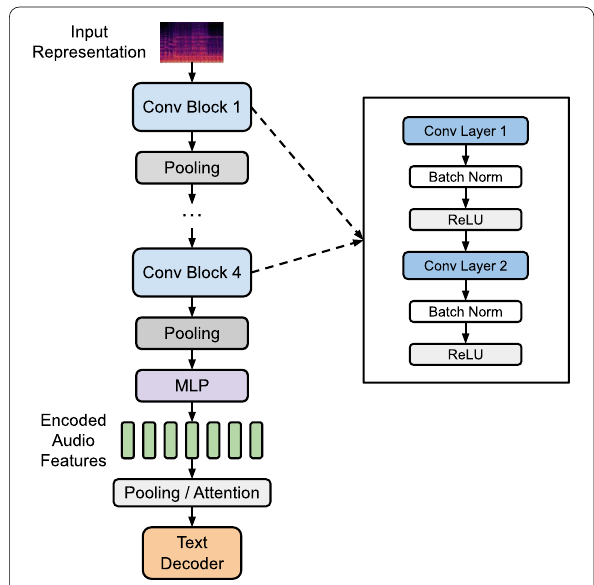
Fig. 3 Diagram of a 10-layer CNN audio encoder. The input representation is first processed via four convolutional blocks and pooling layers, where each block consists of two convolutional layers. The feature maps output by the last convolutional block are then averaged along the frequency axis and fed into a two-layer multi-layer perceptron (MLP) to obtain encoded audio